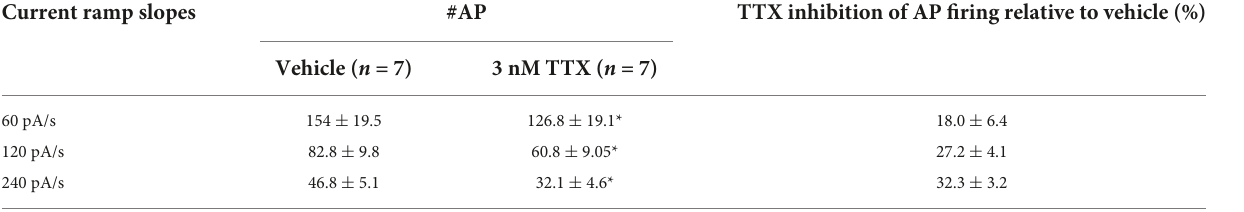
TABLE 2 Sensitivity of TTX on AP firing at different current ramp